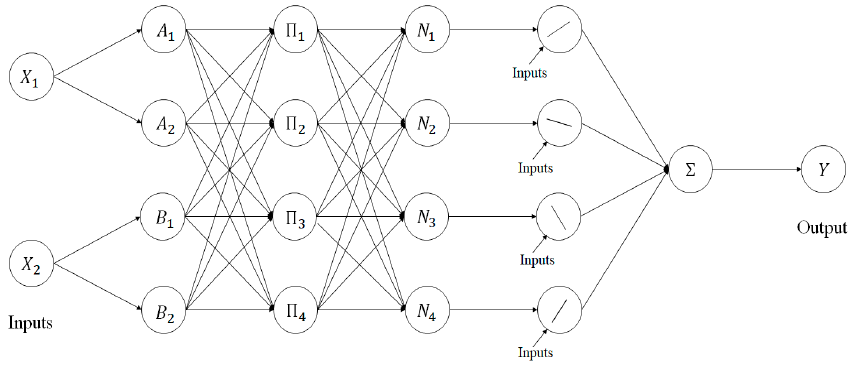
Figure 2. ANFIS structure.